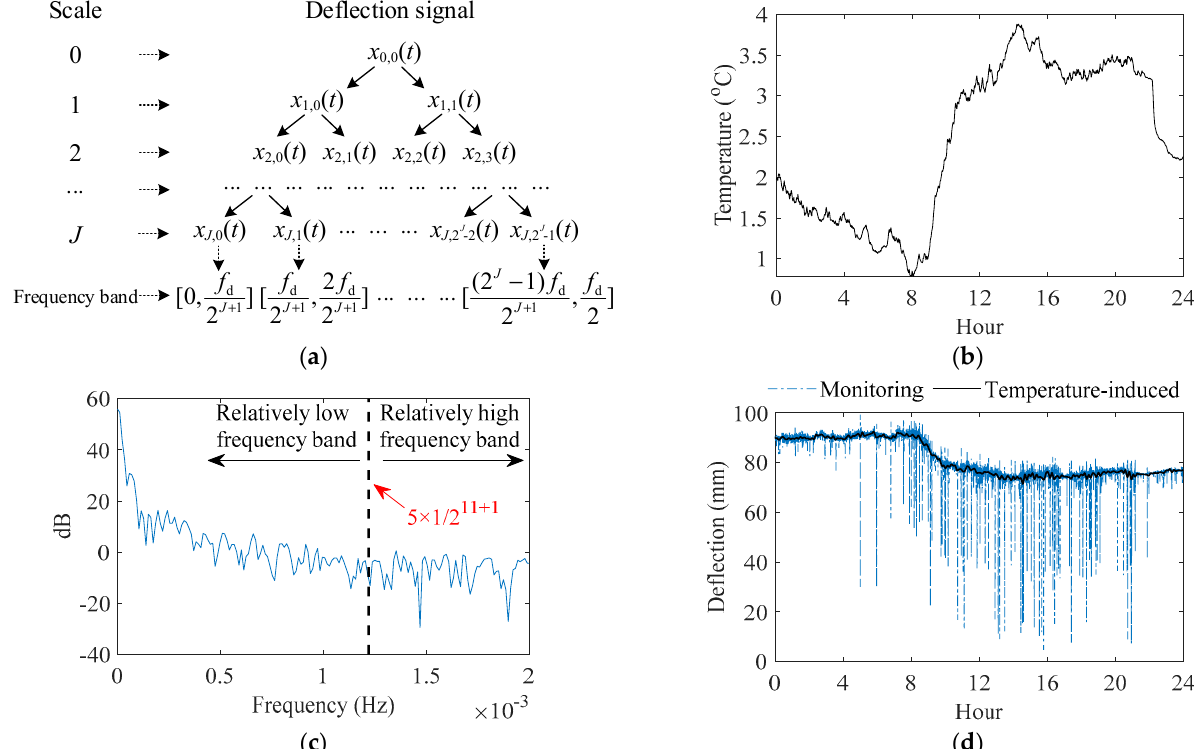
Figure 3. Determination of temperature-induced deflection by wavelet transform: ( a ) decomposition tree of signal by J -scale wavelet packet; ( b ) temperature data; ( c ) frequency spectrum of temperature data; ( d ) deflection data and its temperature-induced part.